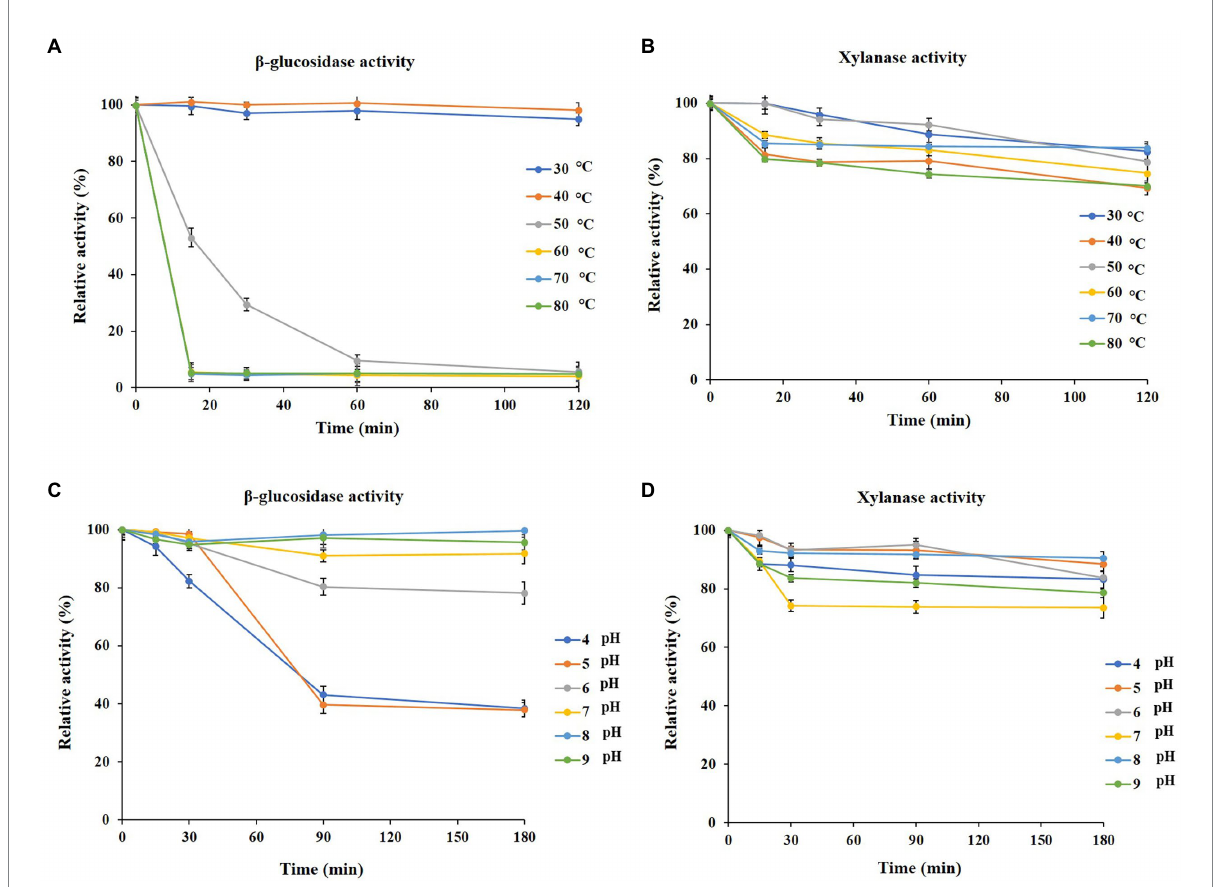
FIGURE 1 Properties of purified PersiBGLXyn1. (A) Effect of temperature on the β -glucosidase stability after 120 min of pre-incubation at 30 to 80 ° C. (B) Effect of temperature on the xylanase stability after 120 min of pre-incubation at 30 to 80 ° C. (C) Effect of pH on β -glucosida stability after 180 min of pre-incubation at pH 4 to 9. (D) Effect of pH on xylanase stability after 180 min of pre-incubation at pH 4 to